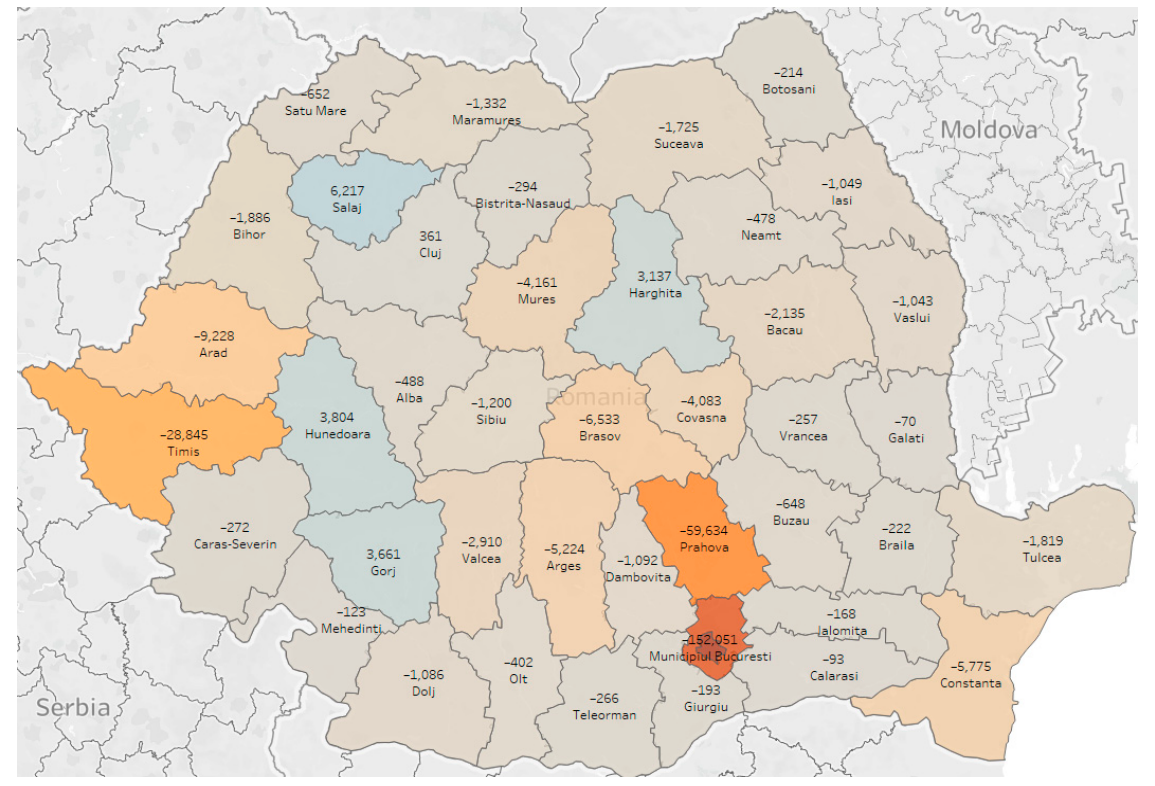
Figure 3. Romania’s trade balance deficit for vegetables, per county, in 2020. Source: authors’ own graphical representation. Table 3. Correlation matrix between vegetable production, imports, and exports.